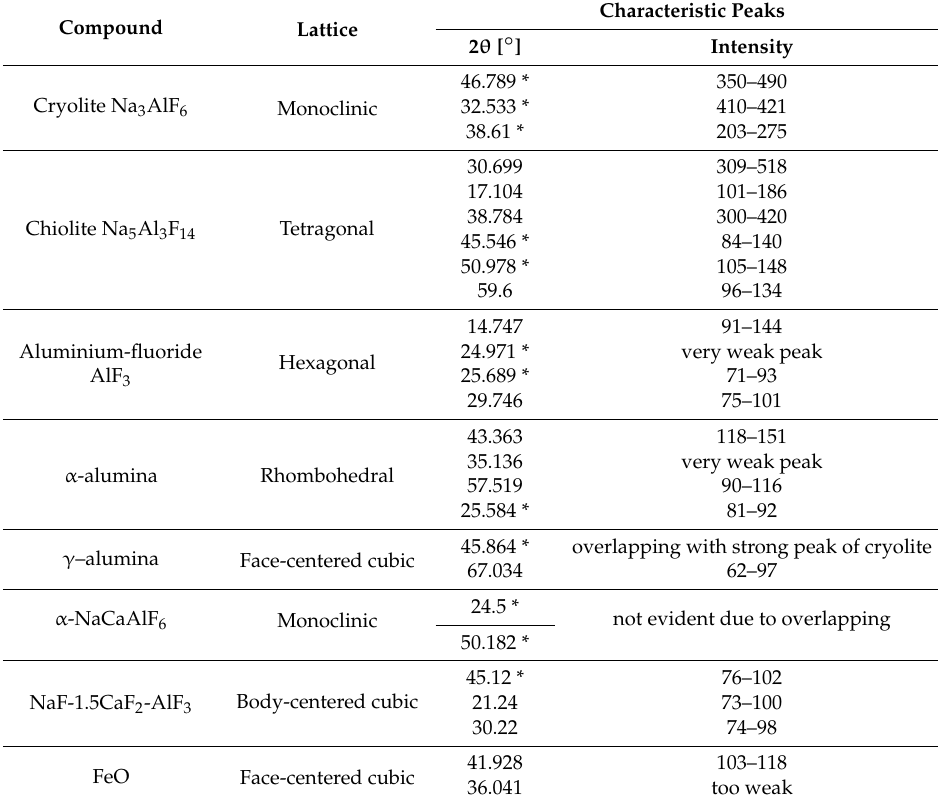
Table 2. Crystalline compounds revealed by XRD in TP, TB, SP, SB